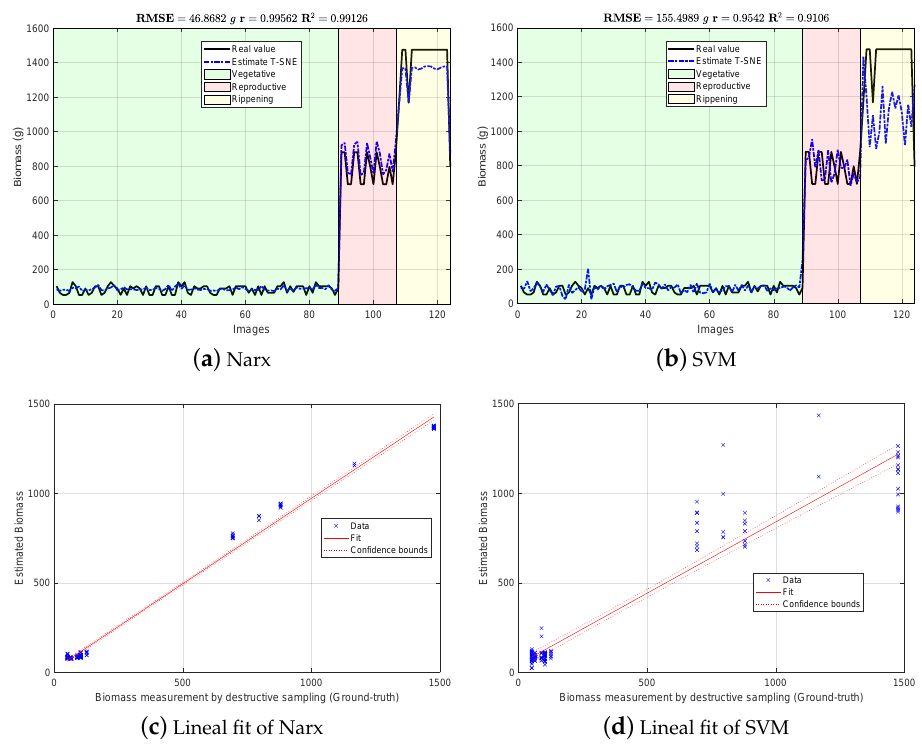
Figure 6. Biomass estimations using the proposed graph-based approach with blue-noise and prior smoothness features